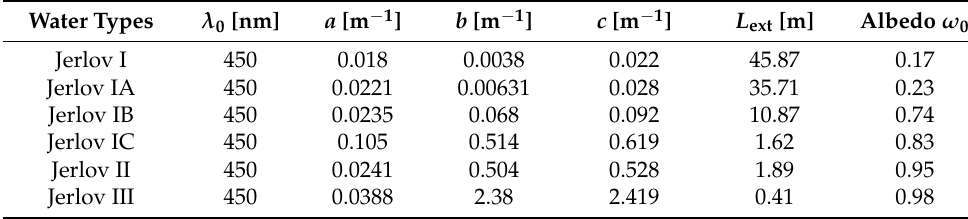
Table 2. Optical characteristics parameters for the various water types